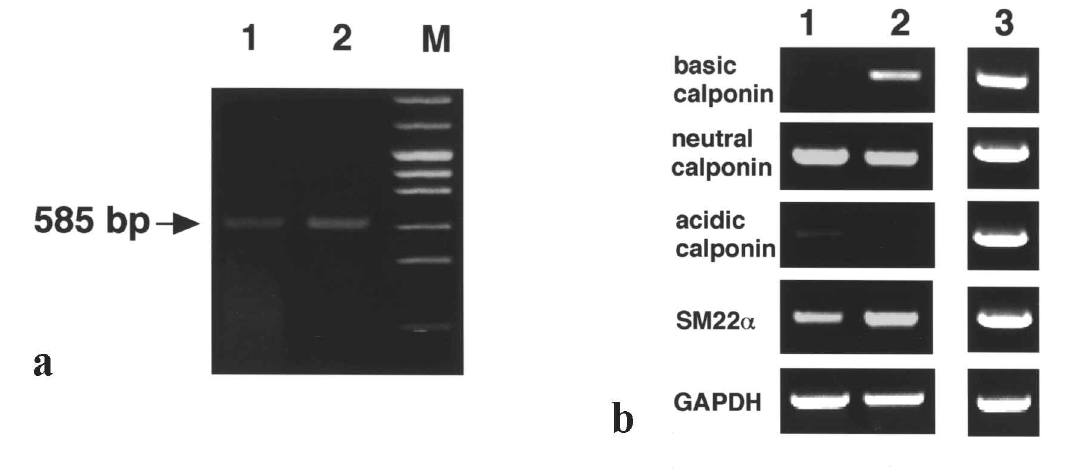
Fig. 2 (a) Detection of SYT-SSX fusion gene expression in synovial sarcoma by RT-PCR analysis. Lane 1: synovial sarcoma (Case 8) (basic calponin immunostaining; ± . Lane 2: synovial sarcoma (Case 1) (basic calponin immunostaining; ++), PCR product of the fusion gene was 585 bp in size. (b) Detection of basic, neutral and acidic calponins, and SM22 a expression in synovial sarcomas by RT-PCR analysis. Lane 1: synovial sarcoma (Case 8) (basic calponin immunostaining; ± ). Lane 2: synovial sarcoma (Case 1) (basic calponin immunostaining; ++). Lane 3: HS-SY-II cells during